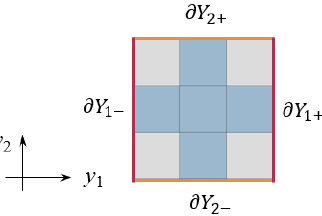
Figure 3. Periodic boundaries of a unit cell of a 2D plate.